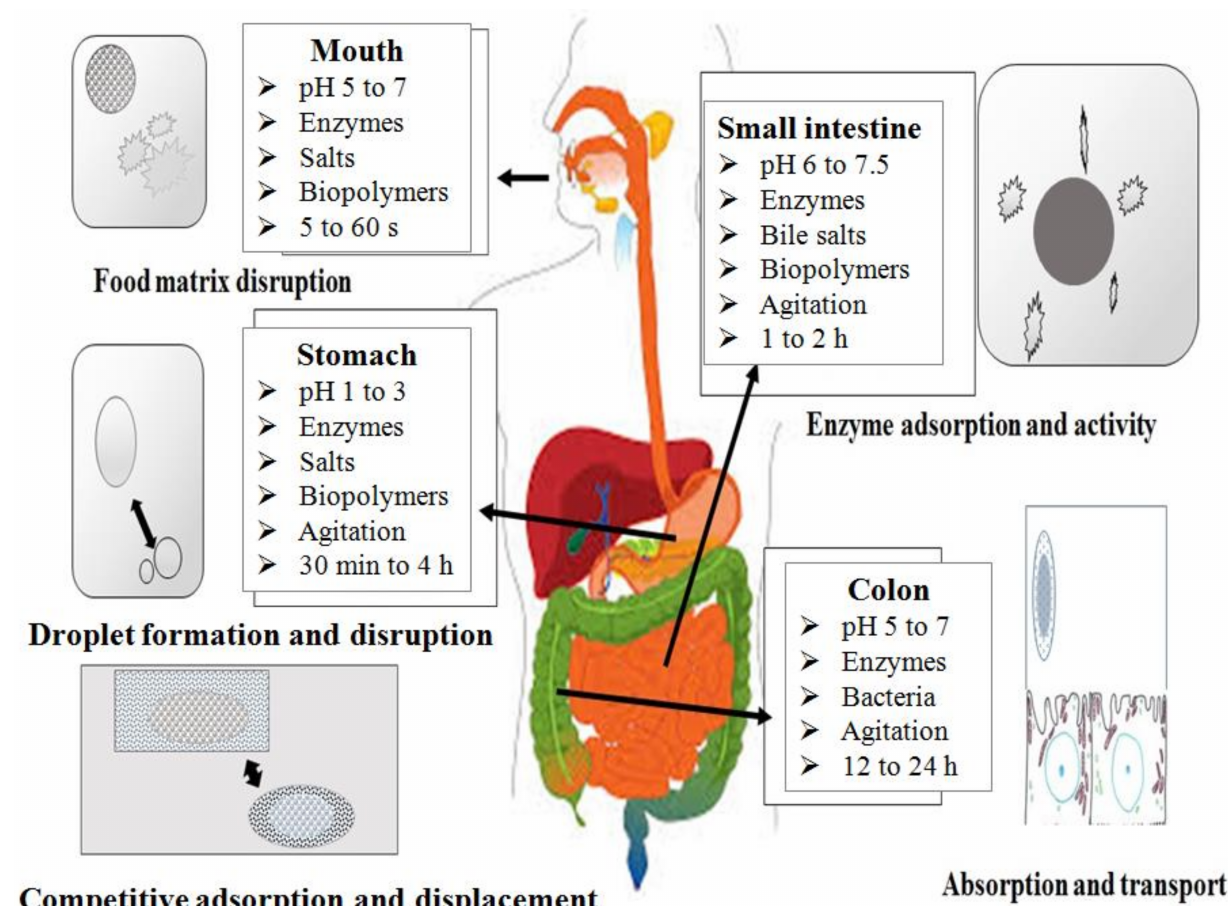
Figure 1. Schematic diagram of the human digestive system and the various physiochemical and physiological processes involved in the digestion and absorption of β